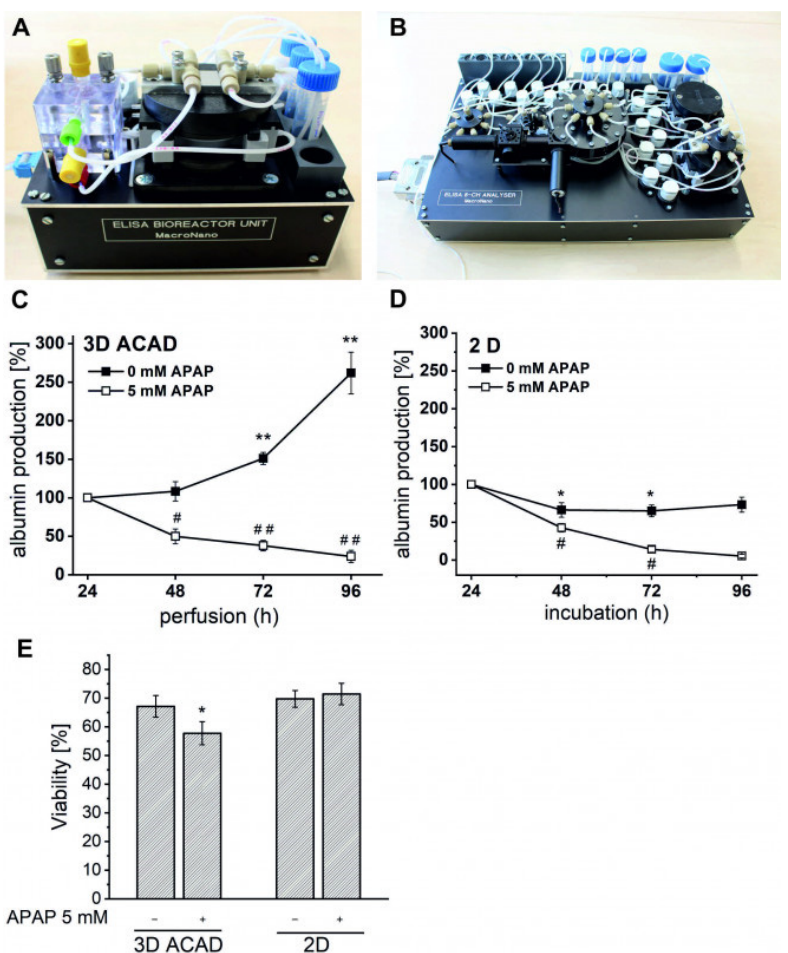
Figure 4. ( A ) The culture unit with the integrated bioreactor and MatriGrid ® scaffold for cell culturing and automated medium exchange. ( B ) The analysis unit for automated albumin concentration measurement. ( C ) Albumin production of HepaRG cells cultured in and measured with 3D-ACAD for 96 h. To monitor initial albumin levels, MatriGrid ® scaffolds with cells were perfused for 24 h with medium. Afterwards, perfusion occurred either with medium alone or medium supplemented with APAP. 0 mM APAP : medium without APAP, 5 mM APAP: medium with 5 mM APAP. Automated medium change and sampling for ELISA measurement was performed every 24 h by the 3D-ACAD. Albumin concentration was normalized to the total cell number (per million). Subsequently, albumin concentration at 24 h was set to 100% and albumin concentrations at 72 h were normalized to the value at 24 h. The mean values ± SE are shown; n = 4 experiments. Changes in albumin production in 3D-ACAD-cultured HepaRG cells perfused with medium or 5 mM APAP were statistically significant: ** p < 0.01; # p < 0.01. ( D ) Albumin production of HepaRG cells cultured in wells for 96 h. The same above-described procedure for 3D-ACAD was performed manually but with static well culturing and daily medium change. Albumin levels in medium supernatants were quantified with a commercial ELISA quantification kit and normalized as described above. The mean values ± SE are shown; n = 2 experiments. ( E ) Viability of cells after 96 h in the 3D-ACAD or wells were determined by measuring cell impedance using a CASY cell counter and analyzer system. Three-dimensional ACAD: n = 4; 2D: n = 2. The reduced viability of HepaRG cells in response to APAP was significant: * p < 0.05. The same experiment was performed with HepaRG cells cultured as monolayers